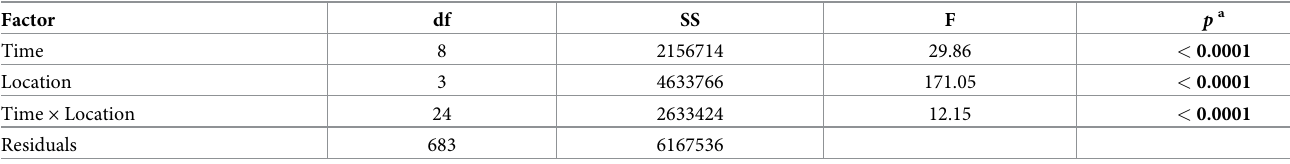
Table 1. Two-way ANOVA results on eelgrass shoot density.